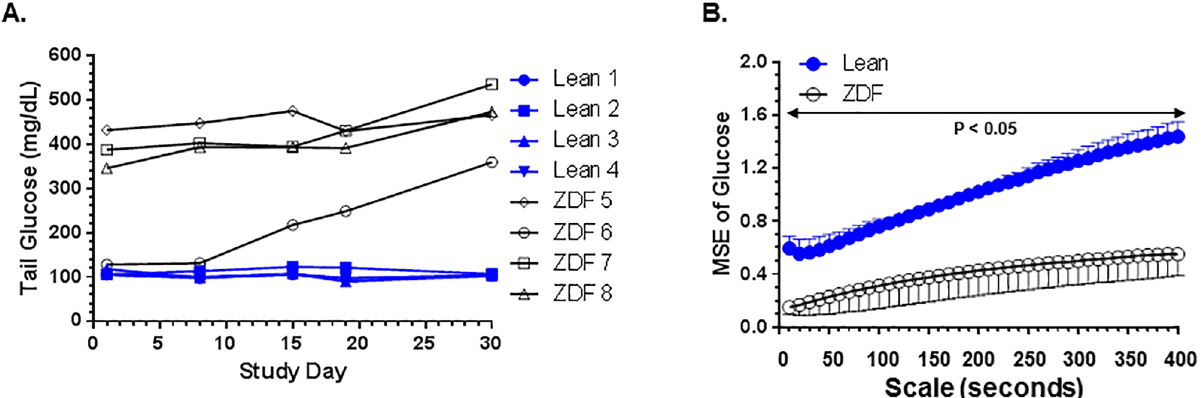
Fig 2. ( A ). Glucose levels of diabetic ZDF rats and age-matched lean controls used for the study. Glucose levels of each rat is shown from Day 1 to Day 30 of study. N = 4 rats/grouop. ( B ). Multiscaleentropy analysison convertedglucoselevels over Day 3 to Day 14 in ZDF rats and lean littermate controls (mean and standarddeviation).The P values in Fig 2B were calculatedby performingunpairedt-tests for differences in mean sample entropy betweenthe two groups of mice at the times scales indicated.